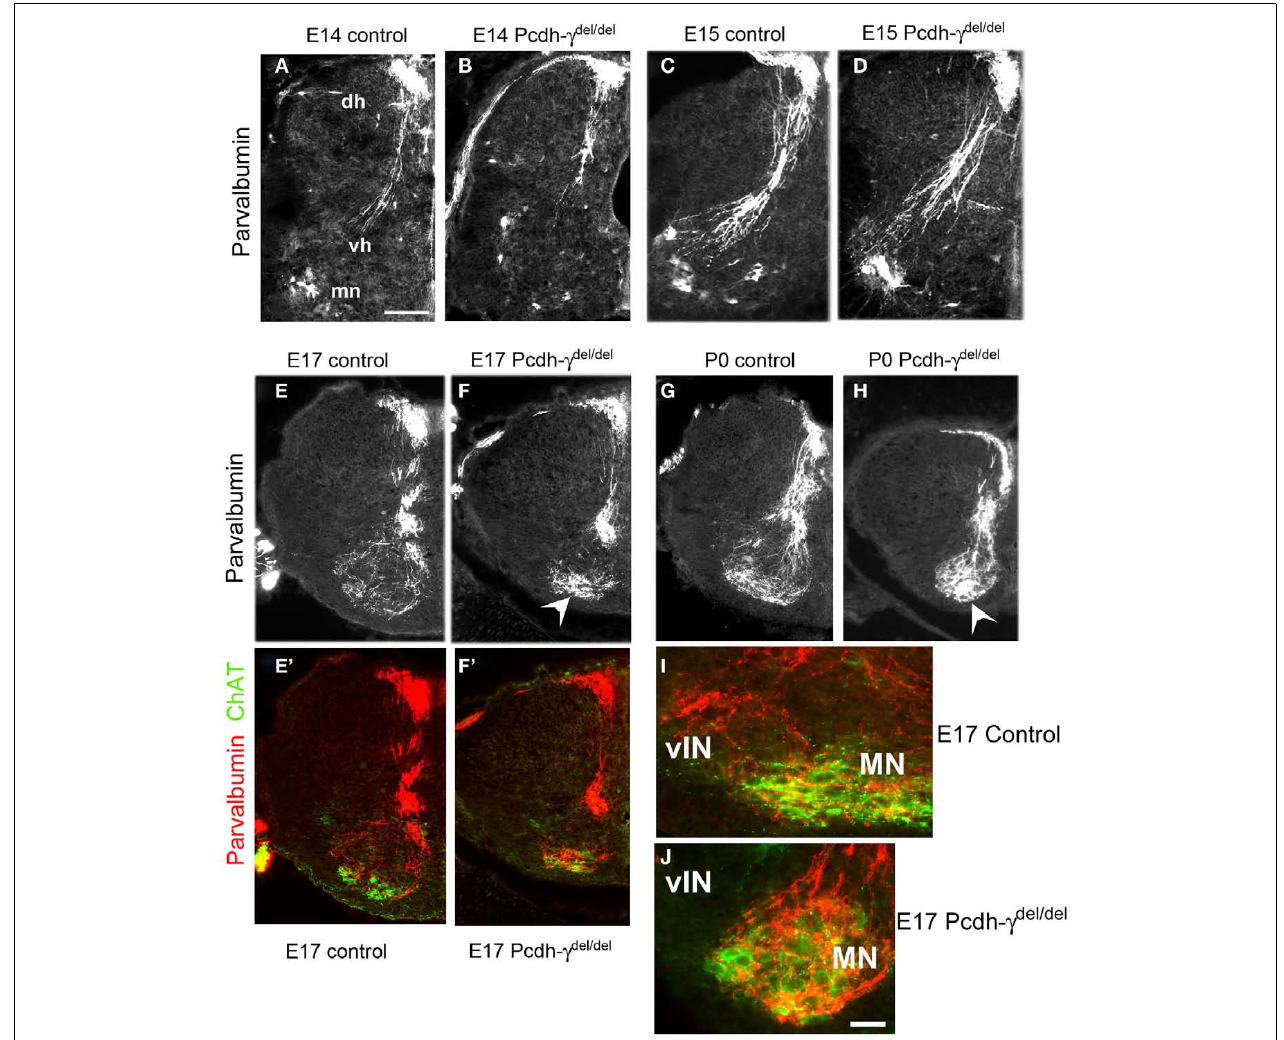
clumped around motor neurons (arrowheads), with a loss of collateral projections to ventral interneurons.This phenotype has worsened by P0. (E (cid:2) ,F (cid:2) ) show the same fields as (E,F) , but with ChAT staining added to indicate where the motor neuron pools are located. Higher magnification views of parvalbumin/ChAT-double stained ventral horn shows that while control Ia axons send collaterals laterally to the ventral interneuron region [vIN, (I) ], these collaterals are absent in mutants (J) (dh, dorsal horn; vh, ventral horn; mn, motor neurons). Scale bar: 100 μ m in (A–H) , 50 in (I,J)